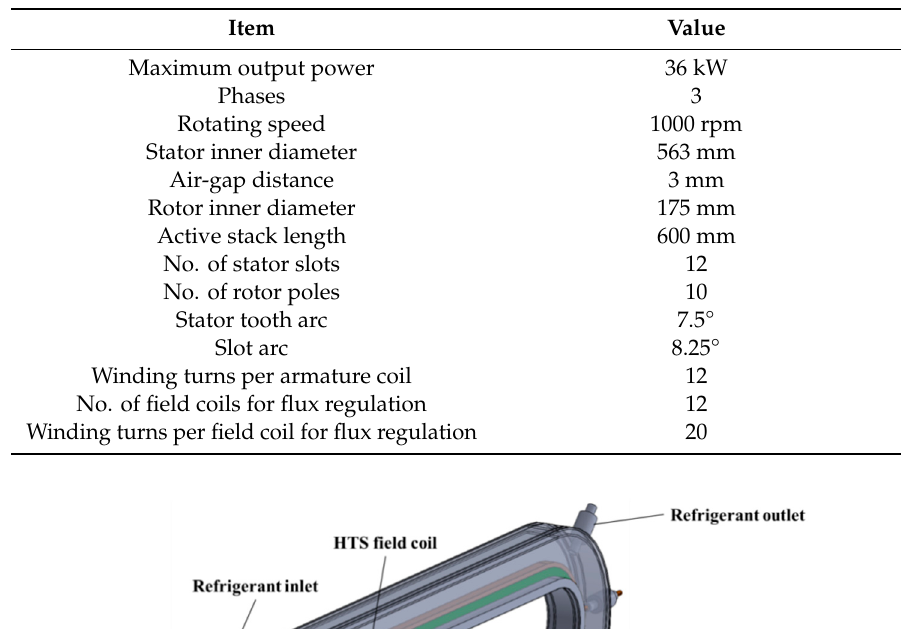
Table 2. Key Design Parameters of the FSM.